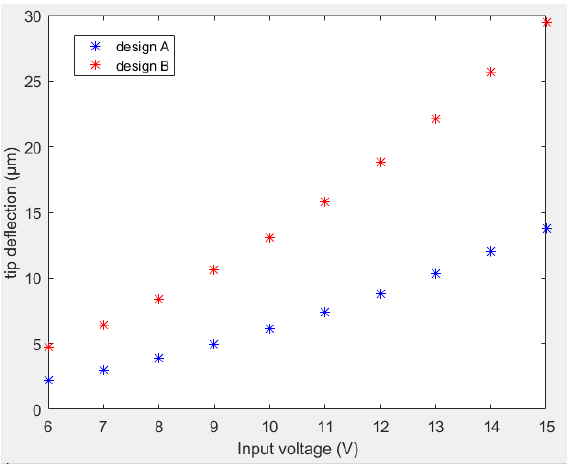
Figure 10. Tip deflection versus input voltage for design A (blue stars) and B (red stars).